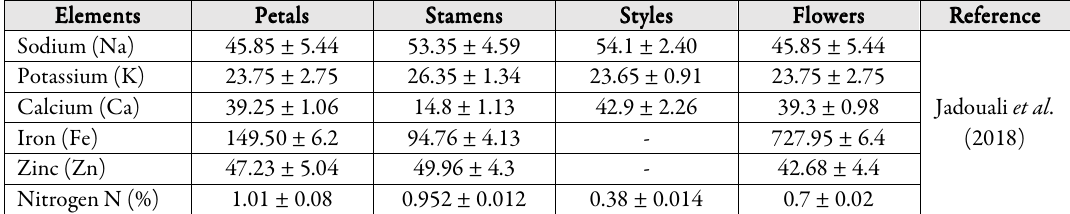
Table 3. Distribution and content of minerals in different parts of C. sativus . Mineral contents